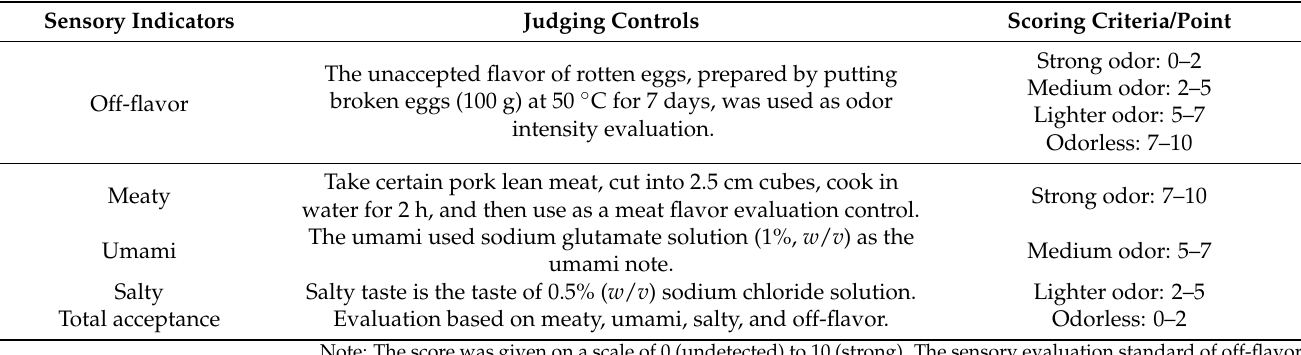
Table 4. Sensory evaluation scoring criteria of MRPs.